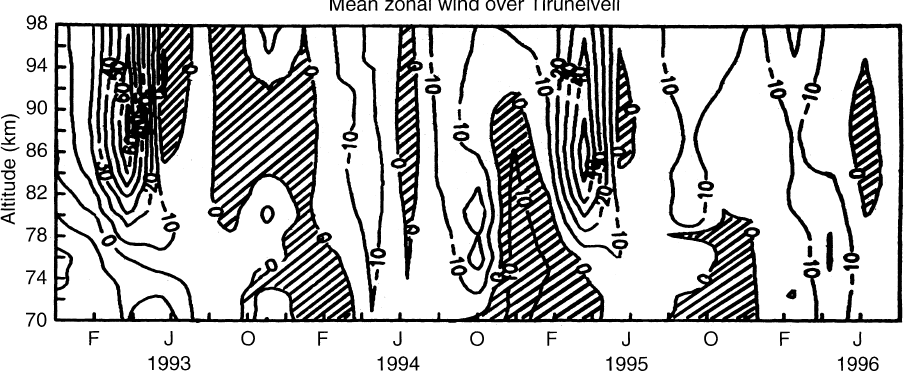
Fig 1. Mean (30-day averaged) zonal wind over Tirunelveli from December 1992 to August 1996. Contours provided with slanted lines represent regimes of